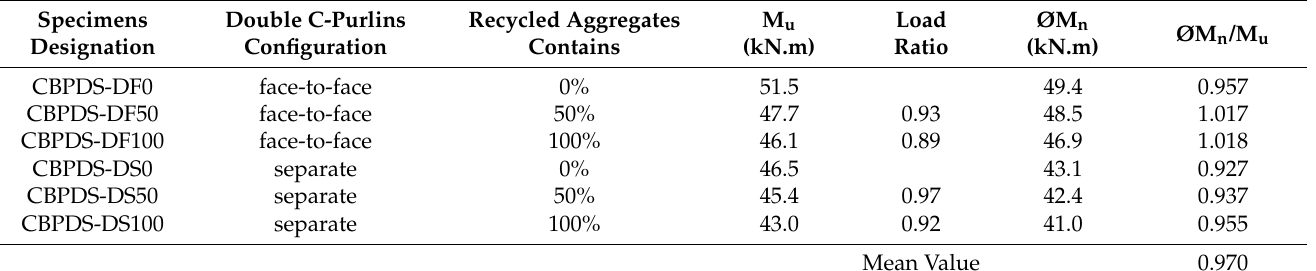
Table 1. Specimens’ designation and tests